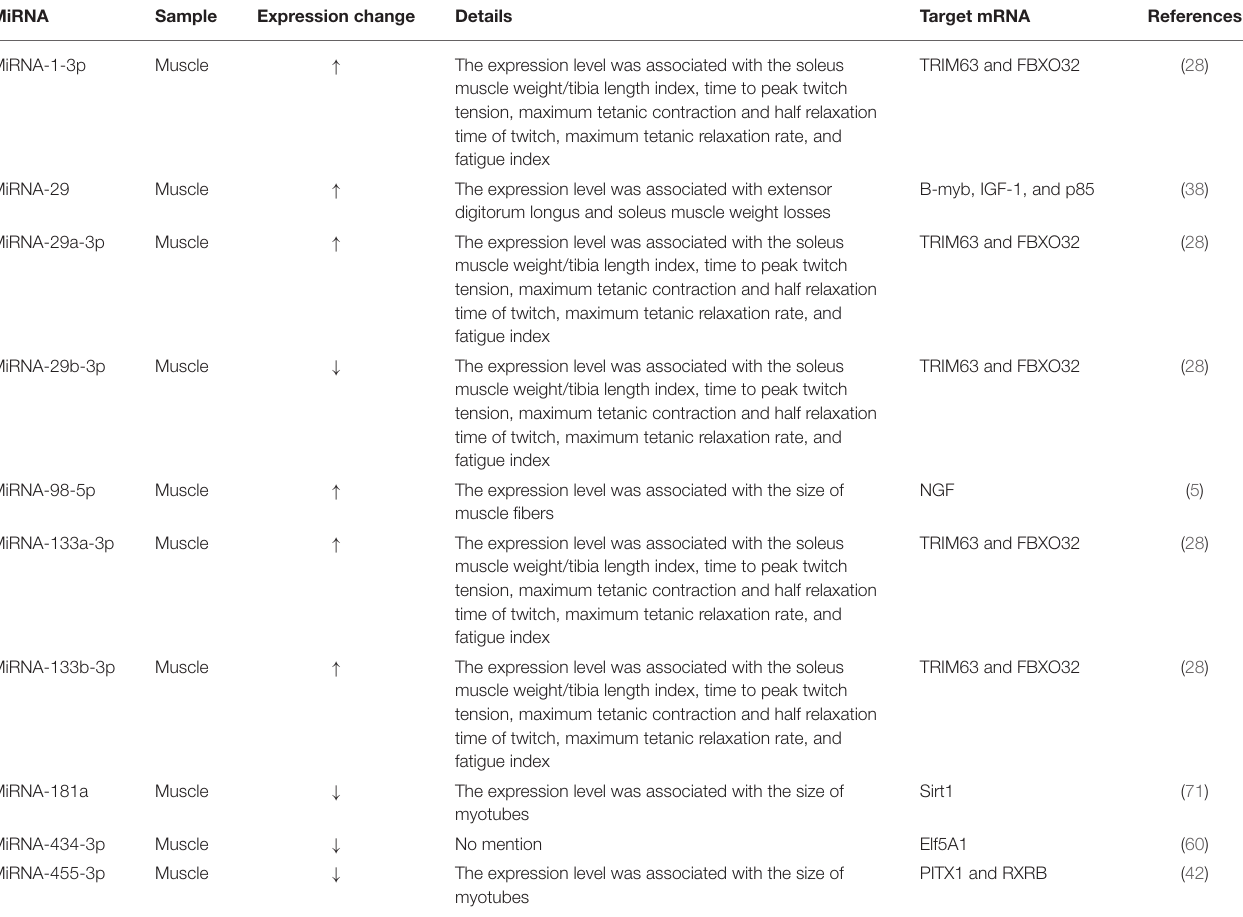
TABLE 2 | Associations between miRNA expression levels and sarcopenia in rodent models. MiRNA